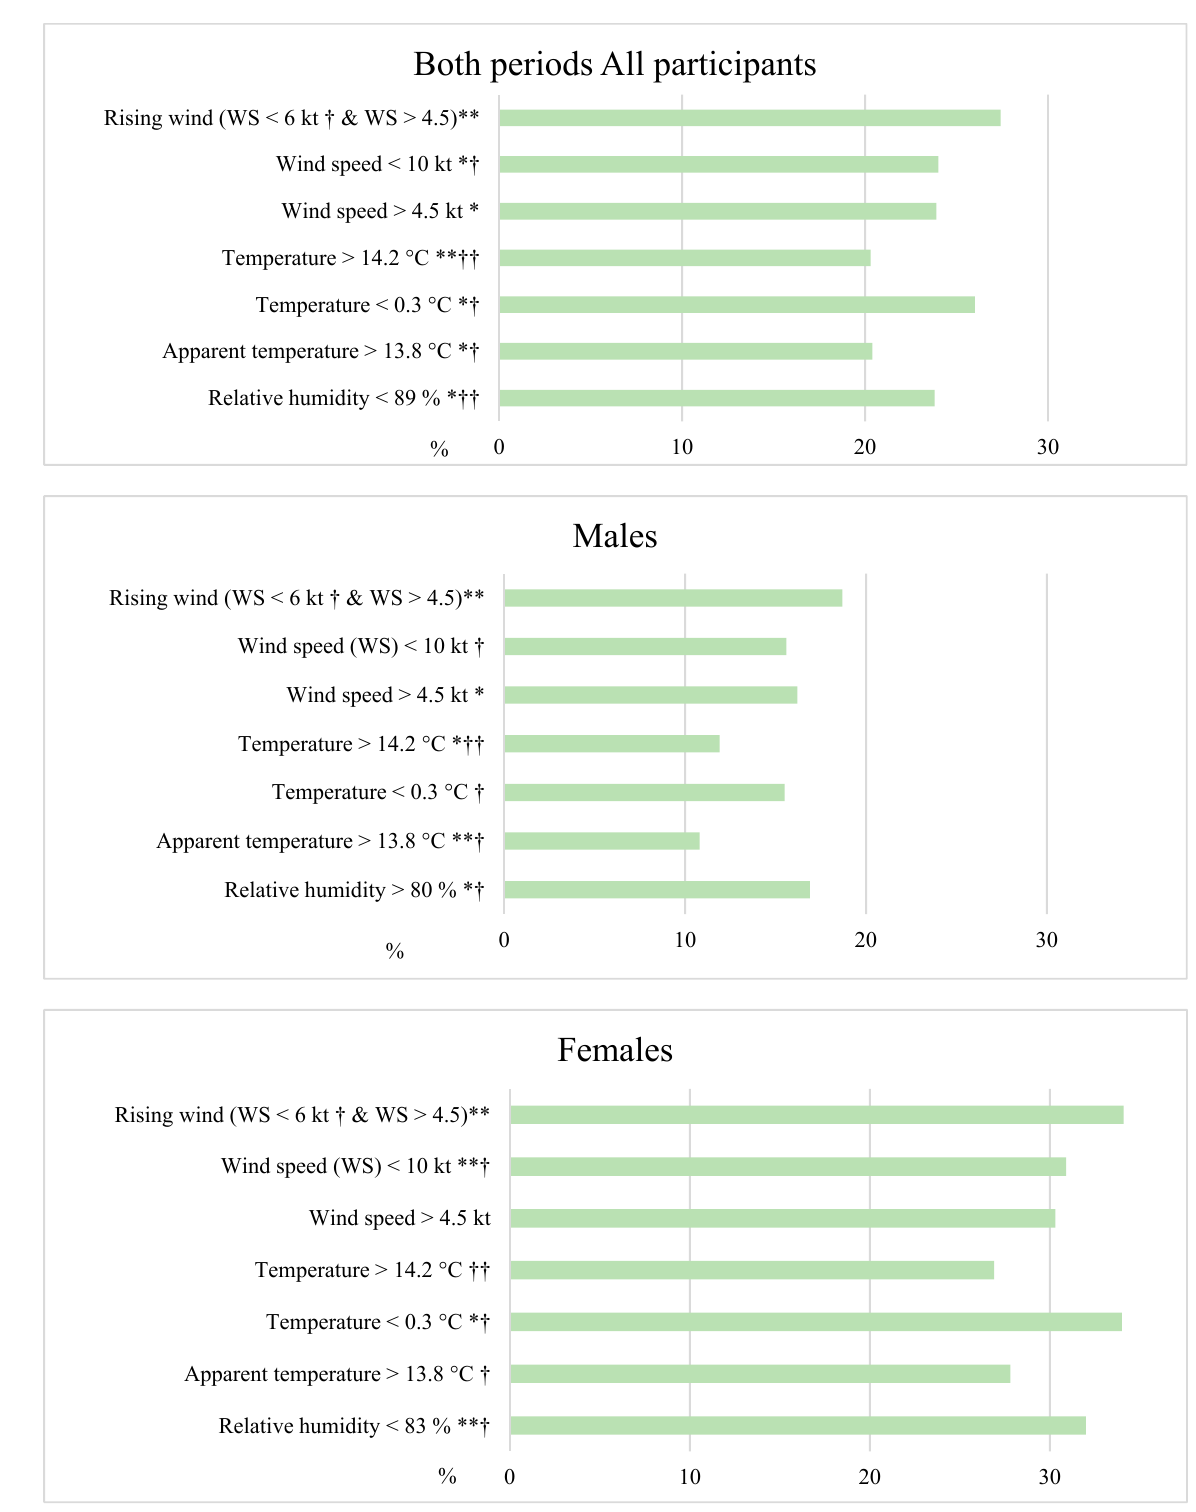
Figure 2. The distribution of the rate of DS by the meteorological factors during the entire period. * p < 0.05, ** p < 0.01; †—the day before the manifestation of depressive symptoms; ††—2 days before the manifestation of depressive symptoms; WS—wind speed. According to the multivariate logistic model for all the participants, the risk of DS was related to female sex (OR = 2.19, 95% CI 1.90–2.54), primary or vocational education (OR = 1.57, 95% CI 1.31–1.88), and physical inactivity (OR = 1.49, 95% CI 1.31–1.70). During